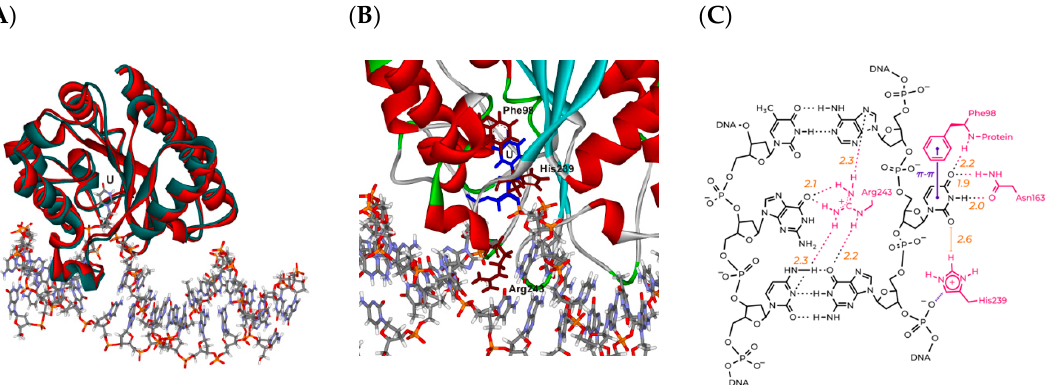
Figure 3. ( A ) An overlay of the structures of free hSMUG1 (red) and of hSMUG1 complexed with DNA (green). The Ura base (U) located in the active-site pocket is also shown. ( B ) Positions of the studied amino acid residues Phe98, His239, and Arg243 in the hSMUG1–DNA complex. ( C ) Schematic representation of contacts formed by Phe98, His239, and Arg243 in the complex of hSMUG1 with DNA.